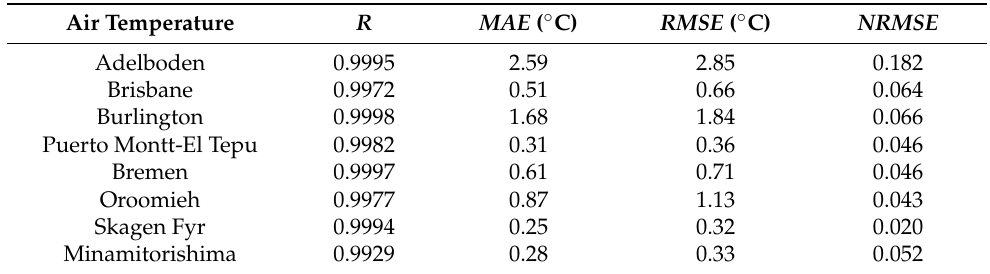
Table 6. Errors and correlation coefficient of monthly average values of air temperature through years 2000–2009.